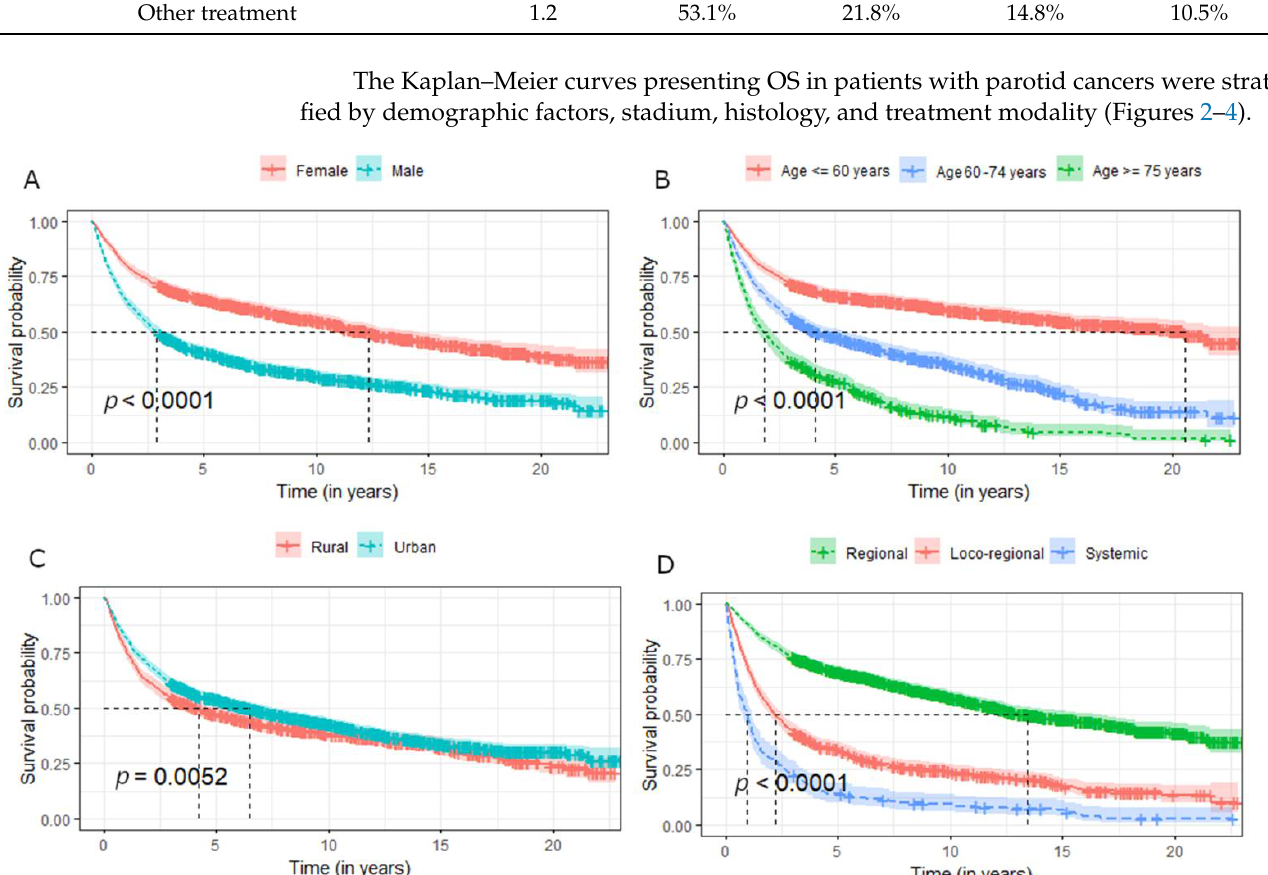
Figure 2. Survival of patients with parotid cancers stratified by demographic factors and stadium of the cancer: ( A ) sex, ( B ) group of age, ( C ) place of residence, ( D ) stadium.